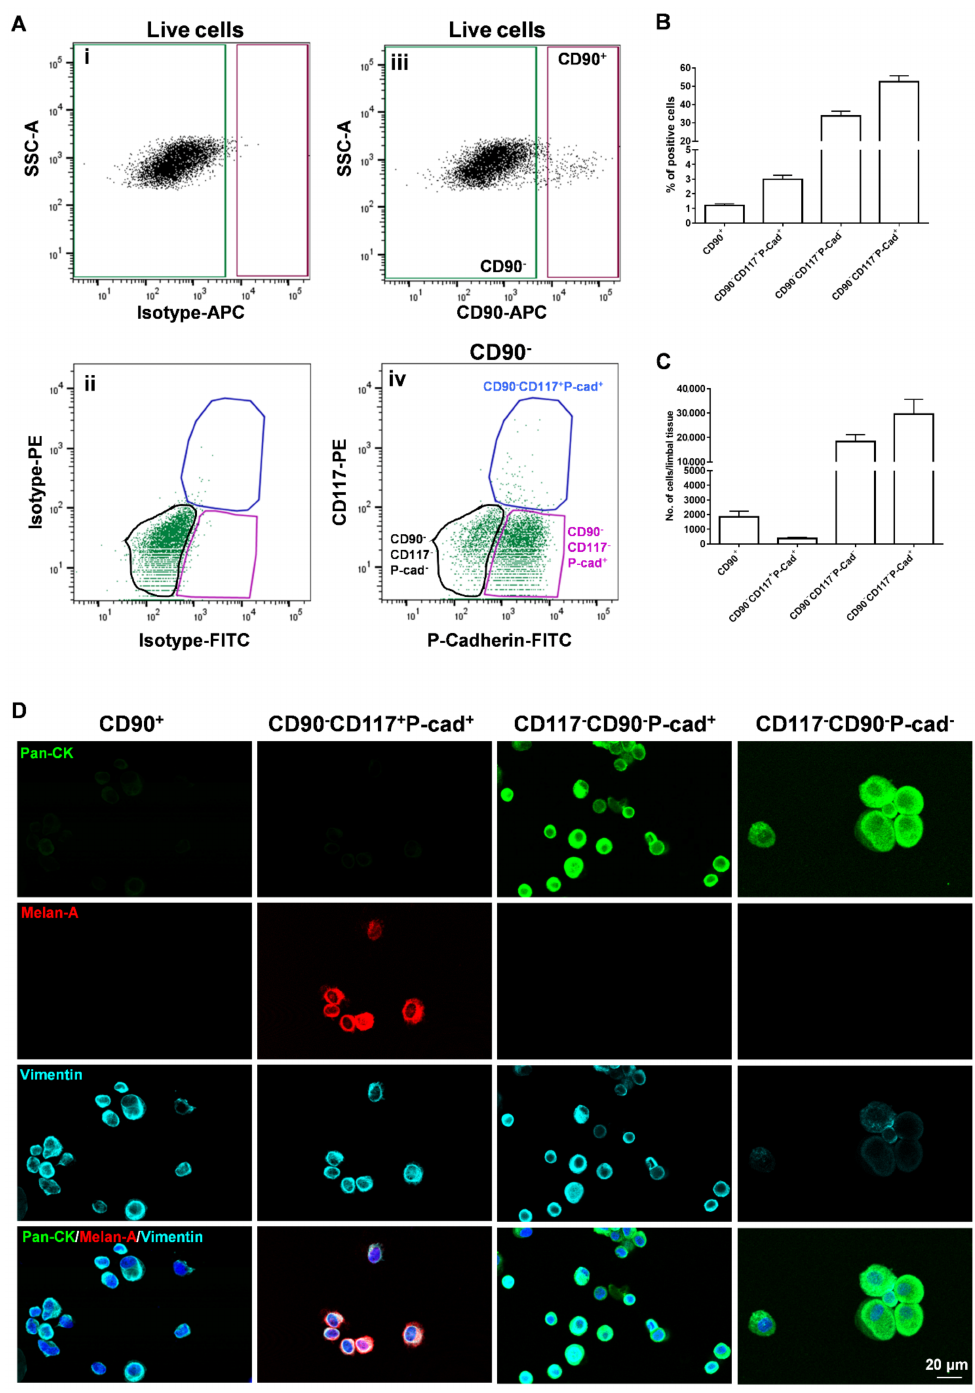
Figure 3. Flow sorting of limbal niche cells and characterization: ( A ) Fluorescence-activated cells sorting (FACS) images demonstrating the gating strategy used to isolate limbal cells. The isotype control graphs (i and ii) showing the set of gates to select CD90 + , CD90 − (iii) cells initially and later for CD90 − CD117 − P-cad + ; CD117 + CD90 − P-cad + ; CD117 − CD90 − P-cad − cells (iv). ( B ) The graph shows the percentage of CD90 + CD117 − , CD90 − CD117 + , CD90 − CD117 − cells obtained from the limbus. Data are expressed as the means ± SEM of 25 individual experiments including 122 corneoscleral tissues. ( C ) The graph shows the number of CD90 + , CD90 − CD117 + P-cad + , CD90 − CD117 − P-cad + and CD90 − CD117 − P-cad − cells obtained from the limbus. Data are expressed as the means ± SEM of 25 individual experiments including 122 corneoscleral tissues. ( D ) Triple immunostaining of cytospin preparations of sorted cells showing vimentin + cells in CD90 + fraction; Melan-A (red) and